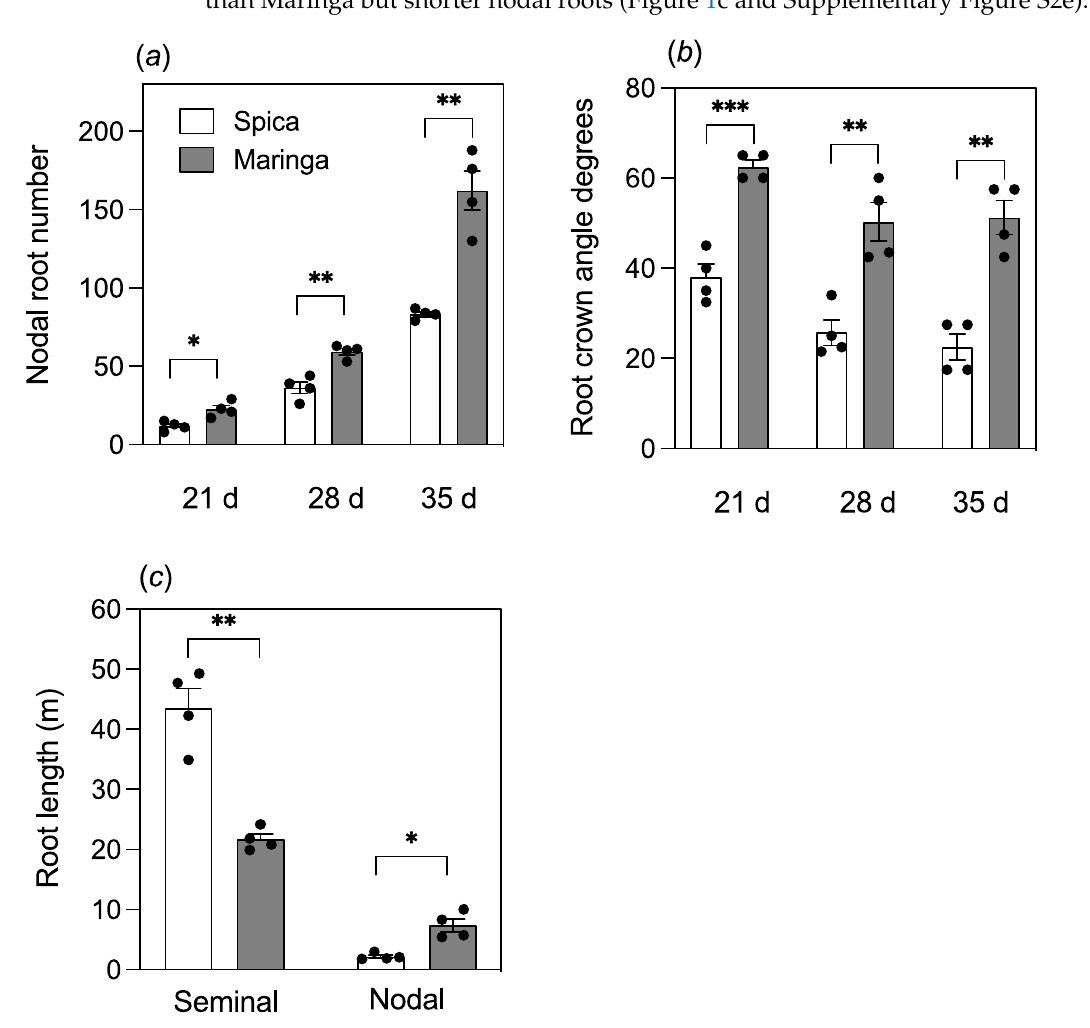
Figure 1. Root morphologies of Spica and Maringa roots differ markedly. Plants were grown in tubes of a well-watered potting soil. Numbers of nodal roots ( a ) and angles of root crowns ( b ) of the two genotypes were measured at each of the three harvests, whereas lengths of seminal and nodal roots were measured at the final harvest ( c ). Individual values are shown as circles, and error bars represent ± SE (standard error) of the mean of four replicates. Data for the genotypes were compared at each harvest with a Student’s t -test (* p < 0.05; ** p < 0.01; *** p < 0.001).